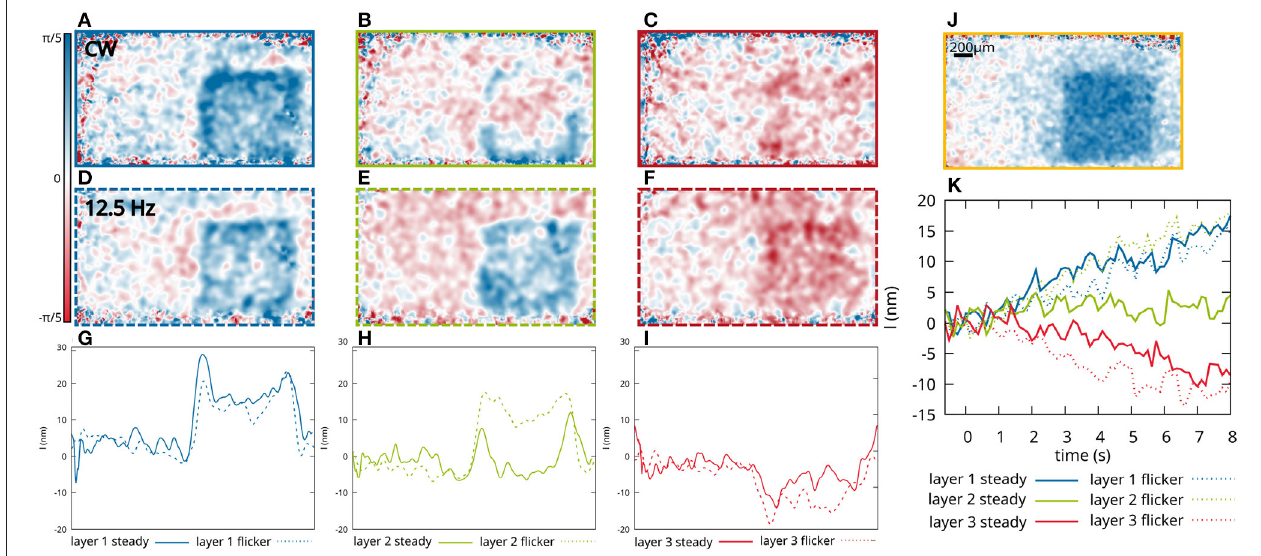
FIGURE 2 | Functional changes of three different layers of the IPL as shown in Figure 1 after 8 s of stimulation with a square-shaped pattern. En-face images of the phase changes after 8 s of continuous stimulation, of the first layer (A) , the second layer (B) and the third layer (C) . En-face images of the optical path length changes after 8 s stimulation with a 12.5 Hz flickering light, of the first layer (D) , the second layer (E) , and the third layer (F) . (G–I) Profile of the optical path length change after 8 s stimulation. The phase changes are vertically averaged over 150 px (600 µ m). (J) For comparison, phase changes in the photoreceptor OS are shown 0.5s after the beginning of the stimulation. (K) Corresponding time courses of the optical path length changes averaged over the central part of the stimulated area.